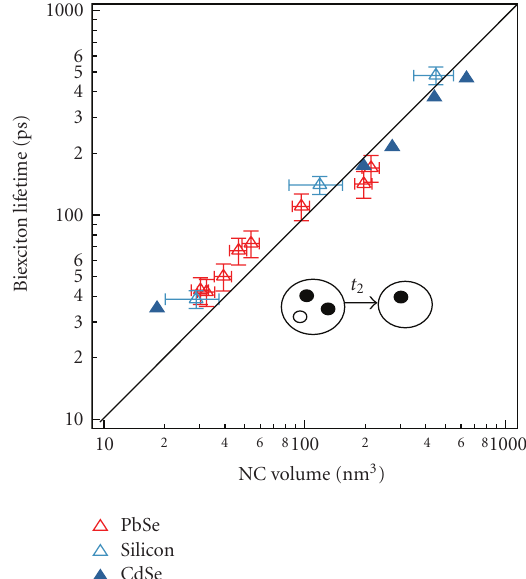
Figure 7: Biexction lifetime as a function of volume of nanocrystal (from [13]).